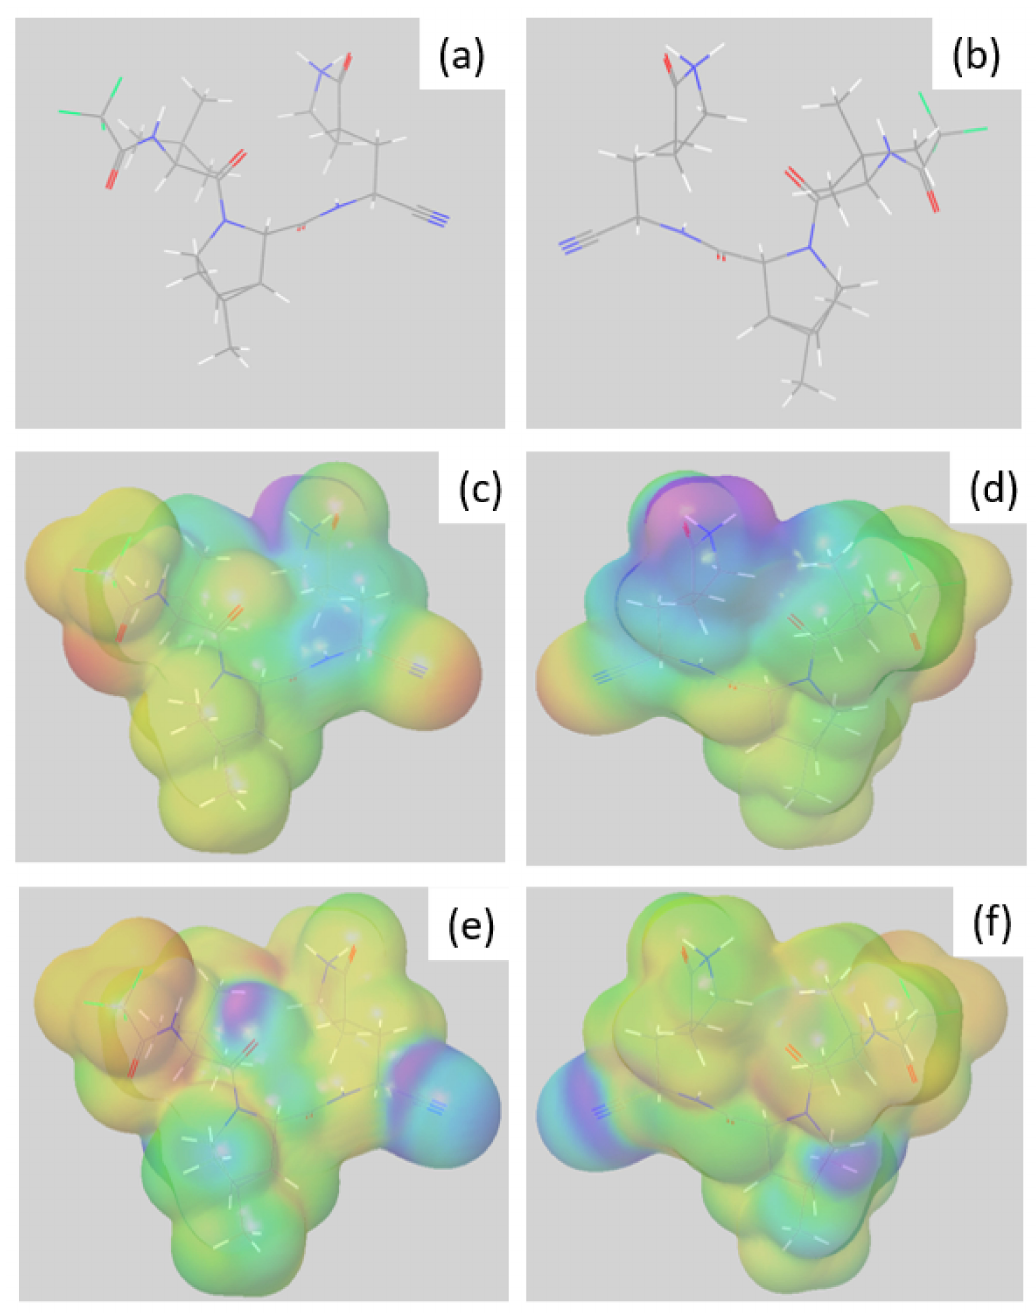
Figure 8. ( a , b ) Structure of optimized geometry of nirmatrelvir’s main conformer at pH = 1; ( c , d ) mapped electrostatic potential; and ( e , f ) mapped Fukui f − function. Regions with the lowest and highest values are mapped in red and purple,